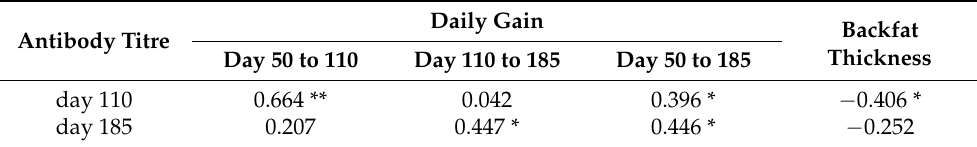
Table 7. Correlation coefficients of antibody titre with daily weight gain and backfat thickness.